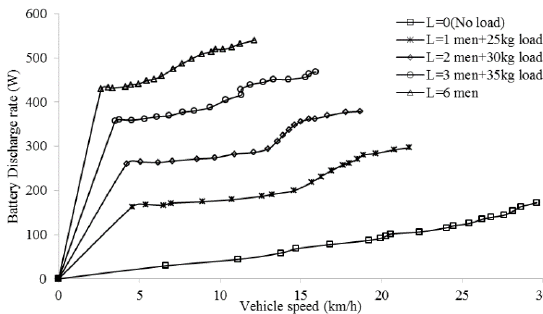
Figure 4. Impact of discharge rate on vehicle speed.